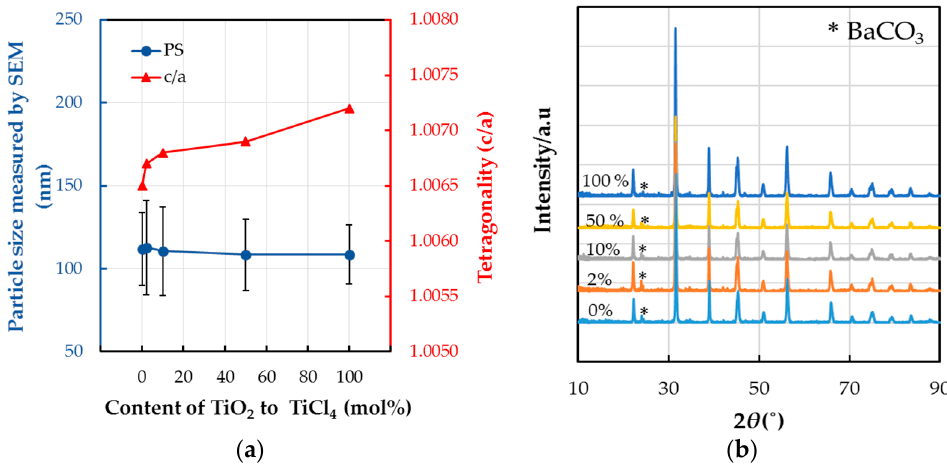
Figure 1. ( a ) The effect of TiO 2 substitution on the size of particles measured by field emission scanning electron microscopy (FE-SEM) and the c/a of pseudo-tetragonal crystallites estimated from the ( b ) XRD pattern corresponding to the two reflection peaks from the (200) and (002) planes. The standard deviation of the particle size, which is shown as vertical bars, decreases as the TiO 2 substitution increases.